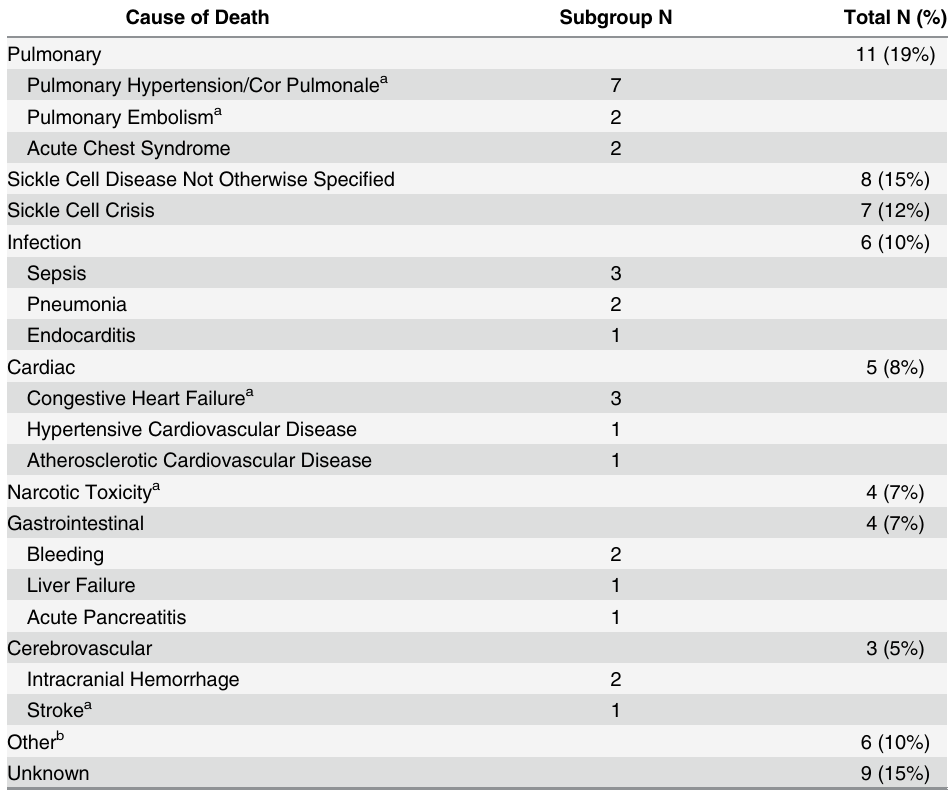
Table 1. Causes of Death in Patients with Homozygous Sickle Cell Disease. Cause of Death Subgroup N Total N (%) Pulmonary 11 (19%) Pulmonary Hypertension/Cor Pulmonale a 7 Pulmonary Embolism a 2 Acute Chest